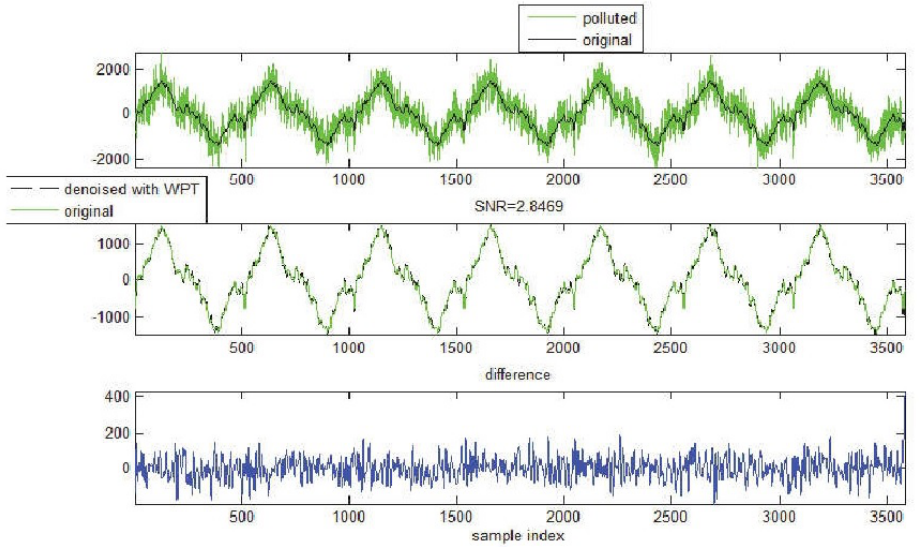
Figure 5. Steady case, most significant noise. Top - Analysed signals (original and polluted). Middle – original signal and signal denoised with WPT. Bottom – di ff erence between original signal and signal denoised with WPT.